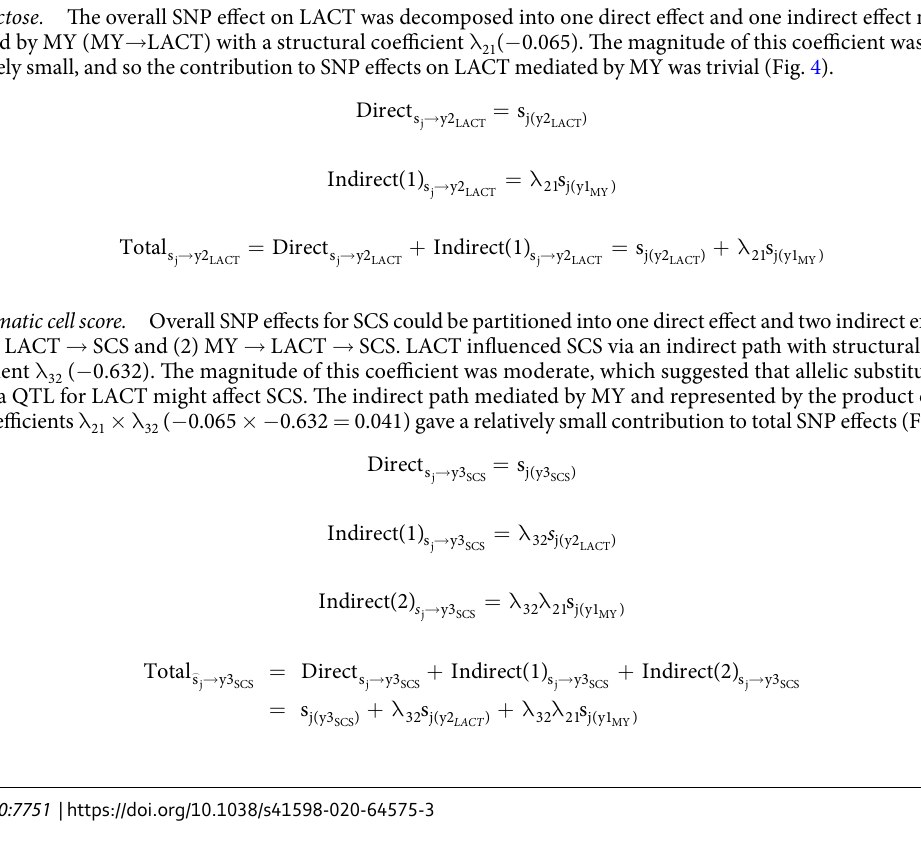
Partitioning of SNP effects. For each trait, SEM-GWAS allowed us to partition SNP effects into direct and one or more indirect effects. The Manhattan plots for SNP effect decomposition are displayed in Figs. 3–7. Milk yield. In the case of MY, the Bayesian network algorithm did not identify any up-stream mediator trait (Fig. 1). Therefore, the genomic architecture of MY was seemingly controlled only by direct SNP effects, i.e., the total effect of the jth SNP on MY corresponds to its own direct effect (Fig. 3).